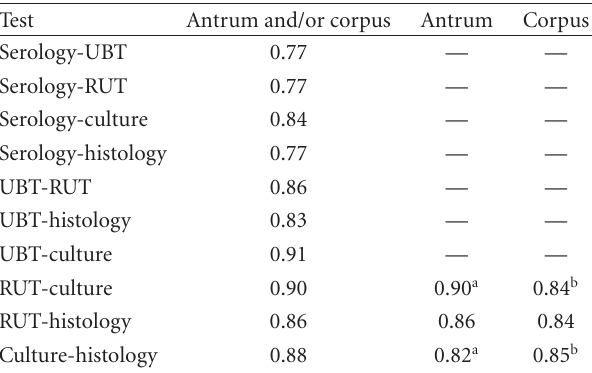
Table 2: Agreement between the results of the tests for H. pylori as evaluated by the Cohen’s kappa coe ffi cient in study population of 304